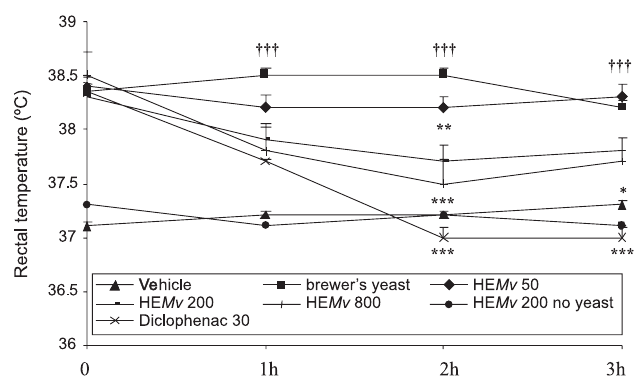
FIGURE 7 - Effect of hydroethanolic extract of M. velame on capsaicin induced nociception in mice. Each value is the mean ± S.E.M. of 7-8 rats. ***p<0.001 compared with control. One-way ANOVA followed by Student-Newman–Keuls.